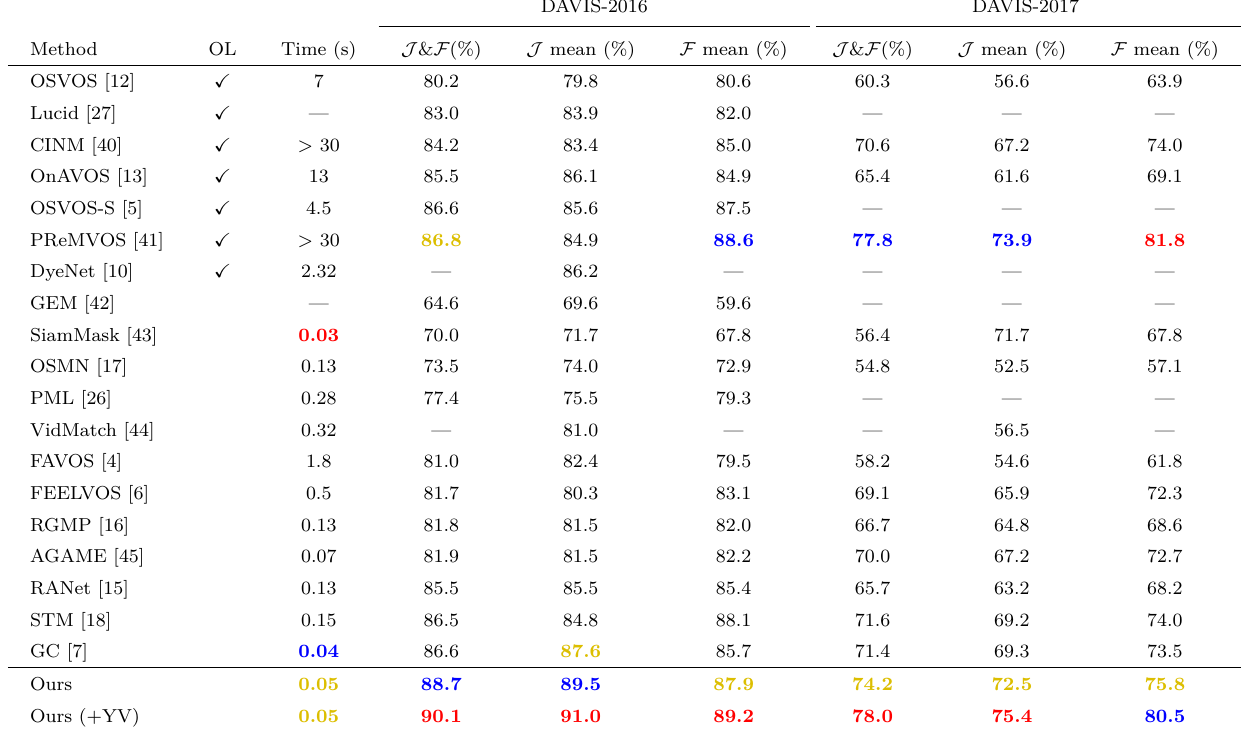
Table 5 Comparison using DAVIS 2016 and DAVIS 2017 validation sets. Results for online (OL) and non-online methods are sorted by J & F mean. +YV indicates use of YouTube-VOS for training. The three best scores are indicated in red, blue, and yellow, respectively (the same for other tables)